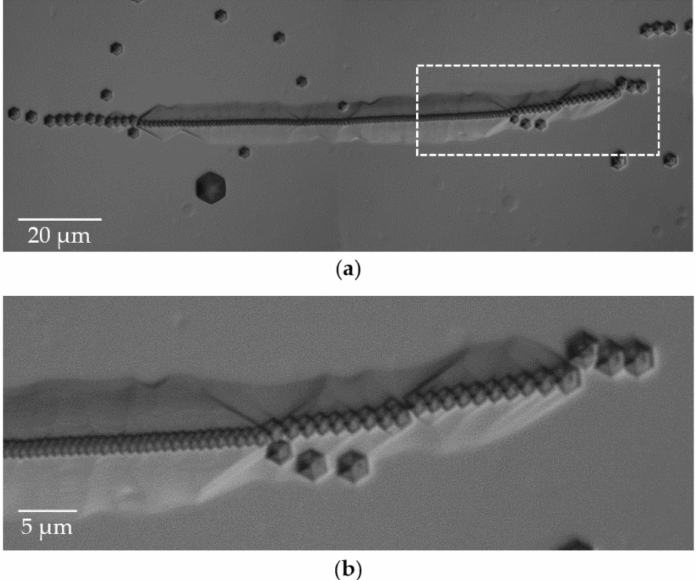
Figure A4. ( a ) DIC optical image of the etched DB-5 of the HCD-A, forming a limited size subgrain boundary (compare Figures 6 and 14f); ( b ) magnified partial view—these are threading edge dis- locations (TEDs), which are predominantly aligned in a line in the a -direction. The distance in the line between individual TEDs is between ~0.5 and 1 µ m. Owing to the small distances, trenches are formed during etching. The smaller the distance between the TEDs, the wider the trenches are